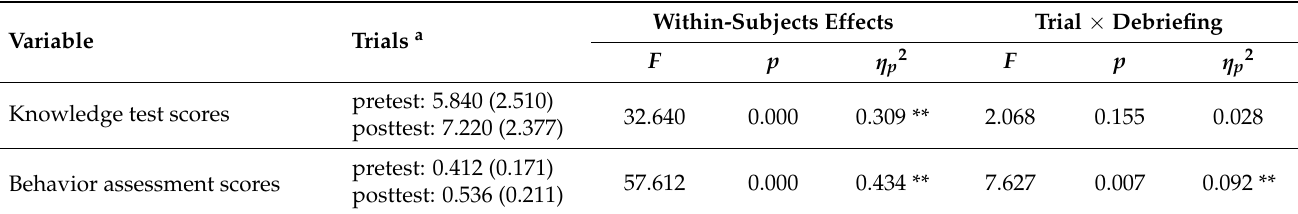
Table 1. Within-subjects effects of the trials and the interaction with debriefing (N = 77).